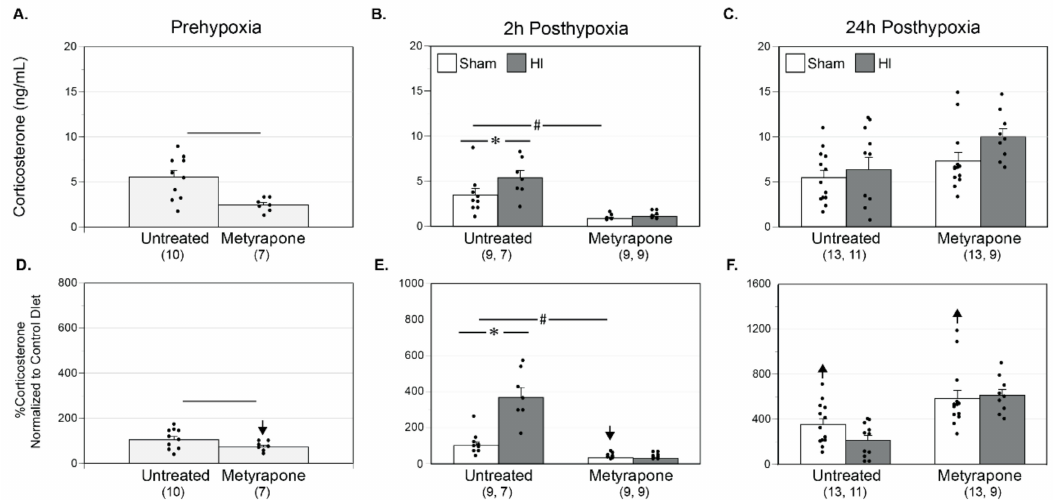
Figure 2. Effects of HI, gestational MET and MUN on the time course of plasma corticosterone. Plasma corticosterone measurements occurred at the time of sacrifice in the four treatment groups at three time points in MUN pups. ( A–C ) depict the effects of MET programming and mild HI on the raw responses of MUN groups. ( D–F ) The isolated effects of MUN alone, obtained by normalizing the raw response to the corresponding responses observed in Control Diet (CD) animals. ( A , D ) Corticosterone concentrations measurements took place immediately before surgery as pre-treatment baseline. ( B , E ) Assessments of corticosterone levels happened 2 h post-hypoxia or normoxia in ligated or Sham-operated animals 24 h prior, respectively. ( C , F ) Analysis of plasma corticosterone also ensued 24 h post-hypoxia or normoxia in Ligated or Sham-operated pups. ( A–C ) Columns and error bars overlaid with dot plots indicate SEM. ANOVA with a post-hoc Fisher’s LSD determined the statistical significance as shown by: solid horizontal bars for significant differences between Untreated and MET baseline groups, * for differences between Sham and HI groups and # for differences between MET-Sham and Untreated-Sham groups. Due to unequal variance for groups portrayed in Figure 2B, an independent t -test determined the significance between Untreated-Sham and HI groups. ( D–F ) Columns and error bars overlaid with dot plots indicate MUN plasma corticosterone values normalized to CD values for each time point. Up and down arrows denote significant differences ( p < 0.05) between normalized values of MUN and 100% for both Untreated- and MET-Sham groups; an up arrow indicates a significant enhancement by MUN whereas a down arrow indicates a significant attenuation by MUN. To improve visual clarity, significant differences between Untreated-HI and MET-HI are not shown. Parentheses at the bottom of each graph display n values for each